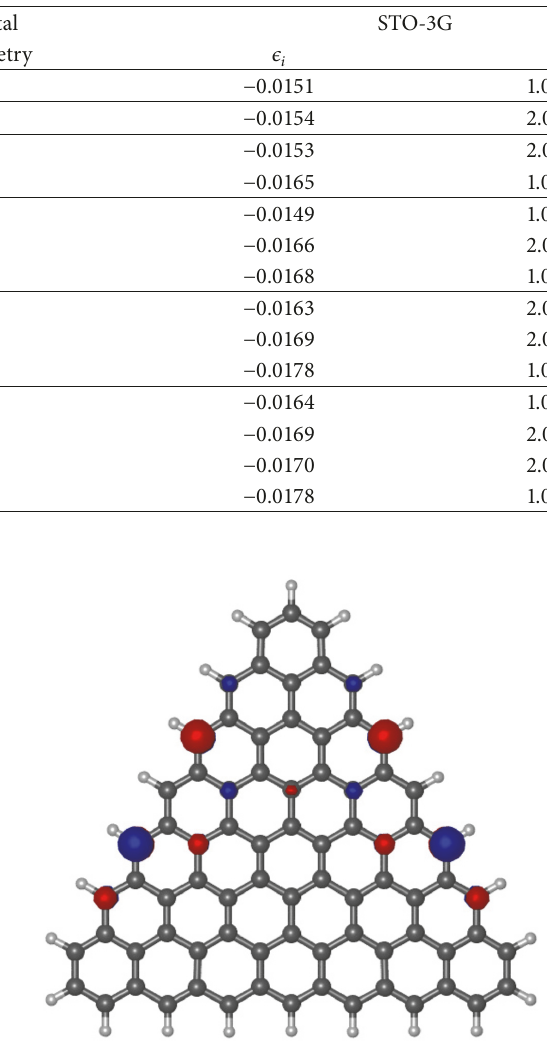
Figure 17: T 7 magnetic orbital 1.